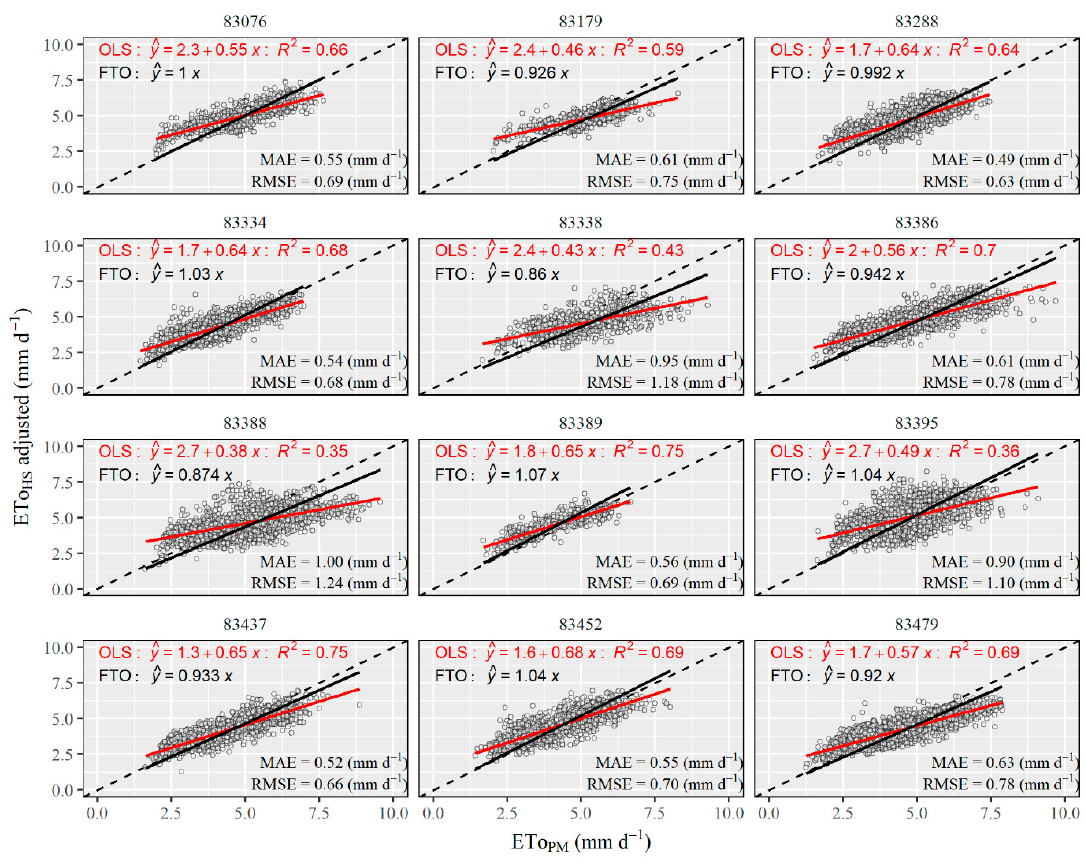
Figure 8. Daily reference evapotranspiration scatterplots between Penman–Monteith and Hargreaves–Samani improved by clustering data by stations and months (approach A4). The red and black lines are the ordinary least squares (OLS) and forced to the origin (FTO) regressions.